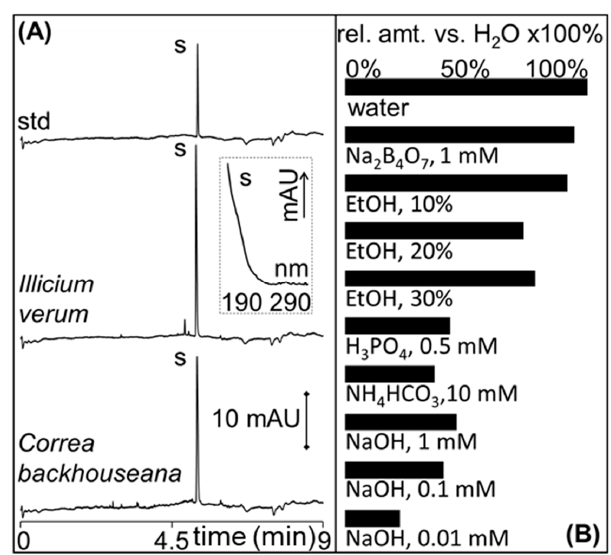
Figure 5. ( A ) Representative capillary zone electrophoresis (CZE) electropherograms of (50 µg/mL) shikimic acid standard (std) and the first PHWE extract with water of Illicium verum (1:50 dilution) and Correa backhouseana (1:20 dilution). The extracts were diluted with water. S is the peak for shikimic acid, and its UV spectrum is shown in the inset. Other conditions are in the Materials and Methods Section. ( B ) Shows the relative amount of shikimic acid found using different extraction solutions versus the amount found using water in PHWE × 100%. Calculations were based on the first 60 mL PHWE extract.